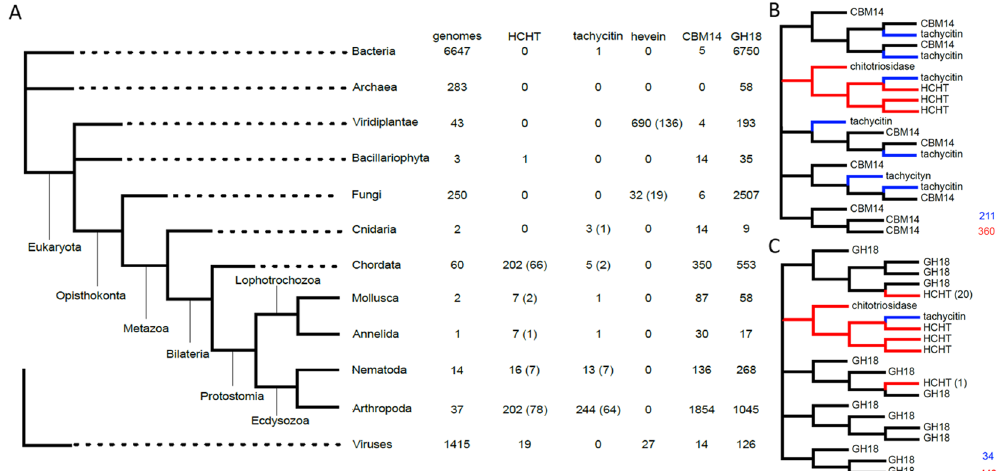
Figure 5. Phylogenetic analyses. ( A ) Reference phylogenetic tree on which are mapped the results of genome mining for chitotriosidase (HCHT-like), tachycitin and hevein proteins, as well as GH18 and CBM14 domains. The number of representative species are written in brackets. ( B ) Schematic tree of CBM14 domains, in which families integrated in HCHT-like architectures are colored in red (families tagged tachycitin are colored in blue). ( C ) Schematic tree of GH18 domains, in which families integrated in HCHT-like architectures are colored in red (families tagged tachycitin shown in